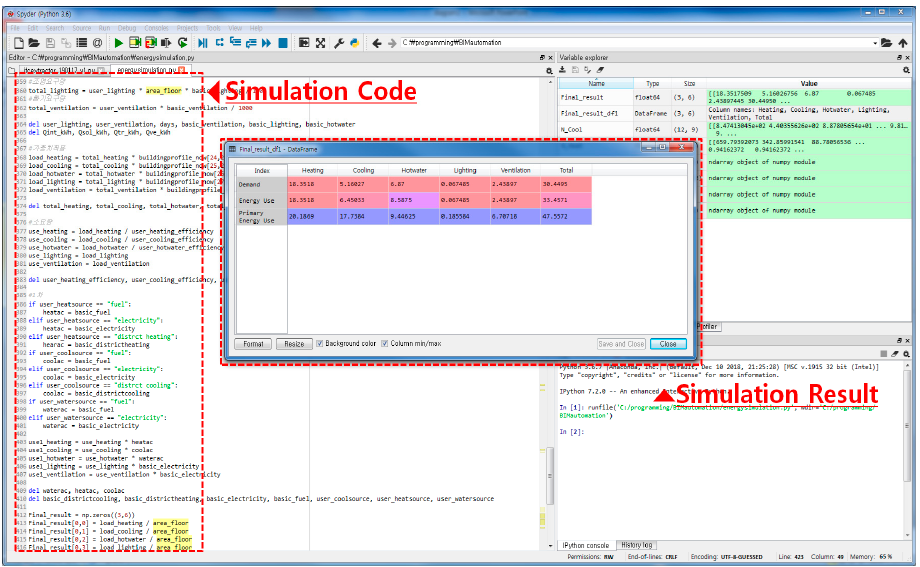
Figure 5. Expansion module (heating and cooling load calculation).